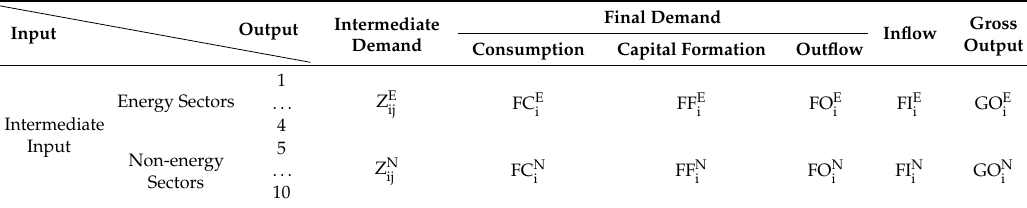
Table 2. Final demand of hybrid input-output